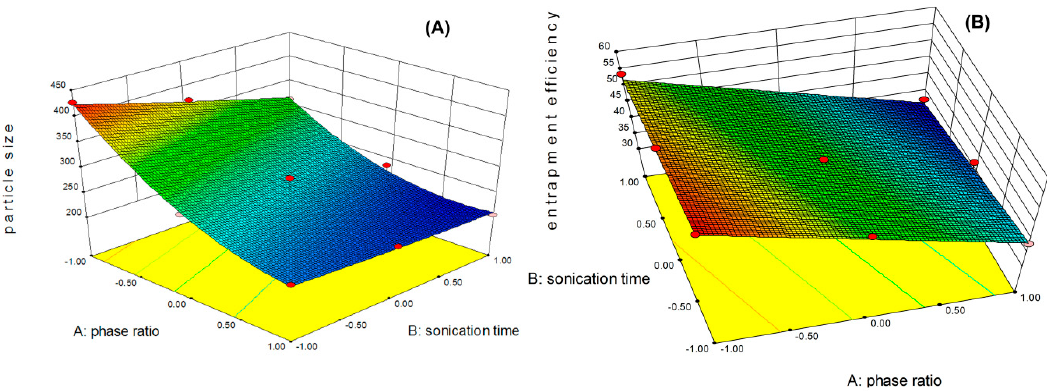
Figure 3. The 3D response surface plot of the responses for particle size Y1 ( A ) and encapsulation efficiency Y2 ( B ).